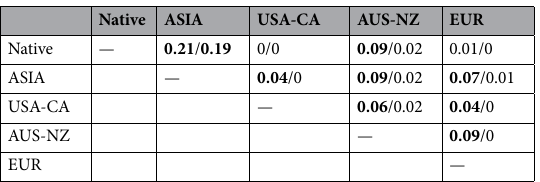
— Table 1. Jaccard index comparisons of similarity among ranges of Lilium lancifolium . The first value corresponds to the Jaccard index measured on minimum-volume ellipsoids (MVE), while the second one on convex polyhedron (CP), representing both the environmental conditions of each region. In bold, Jaccard indices >